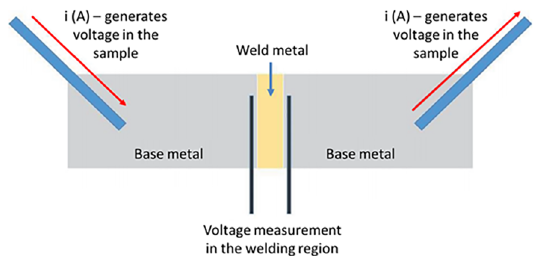
Figure 3. Schematic diagram of the voltage measurement for the welding region electrical resistance